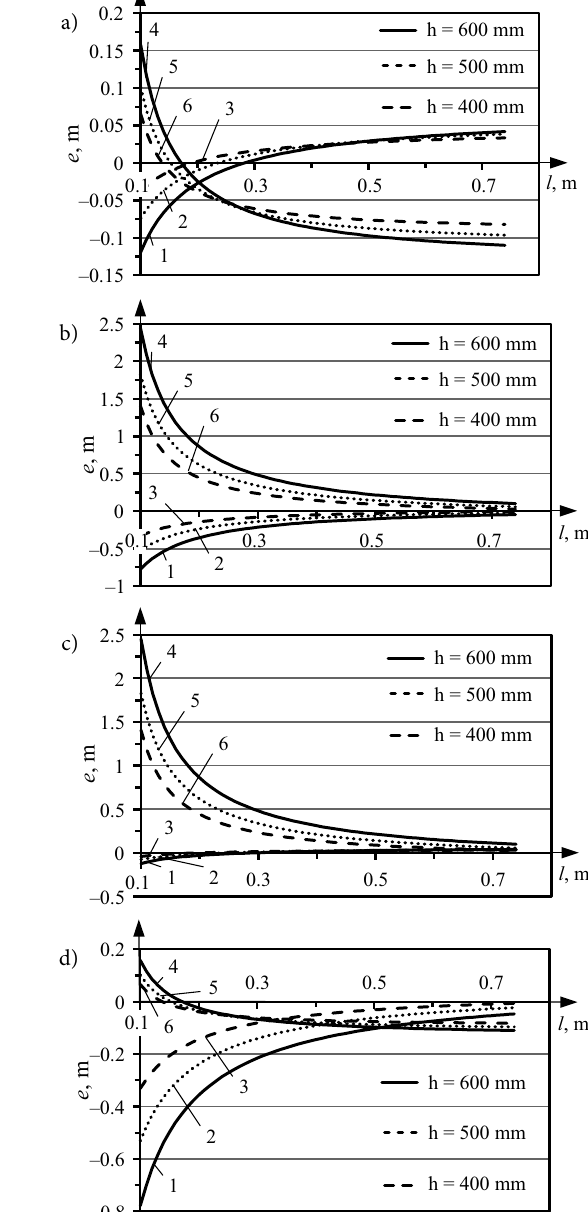
Fig. 6. Permissible limits of pretensioned strand position: a) when cracks aren’t allowed at transfer and at service; b) when cracks are allowed at transfer and service; c) when cracks aren’t allowed at transfer, but are allowed at service; d) when cracks are allowed at transfer, but aren’t allowed at service: 1, 2 – respectively eccentricity at transfer and at service by estimating linear variation of strand stresses; 3, 4 – respectively eccentricity at transfer and at service by estimating constant strand stresses